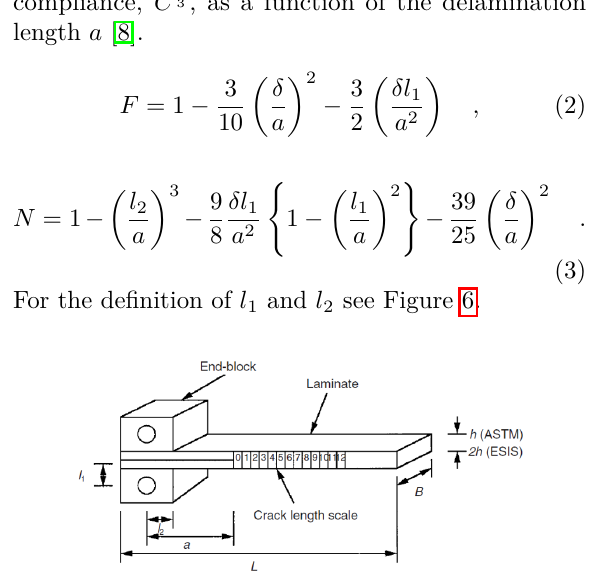
Figure 6. Mode I Double Cantilever Beam (DCB) specimen (reprinted from [8])